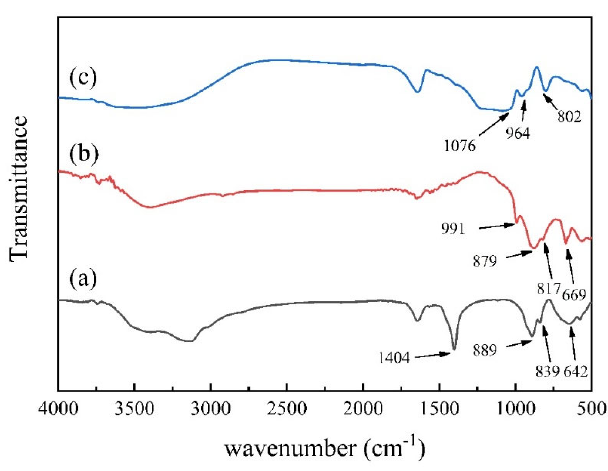
Figure 1. FT-IR spectra of ammonium molybdate (a), MoO 3 (b), and Ce/MoO 3 /SiO 2 Figure 1. FT ‐ IR spectra of ammonium molybdate ( a ), MoO 3 ( b ), and Ce/MoO 3 /SiO 2 ( c ).